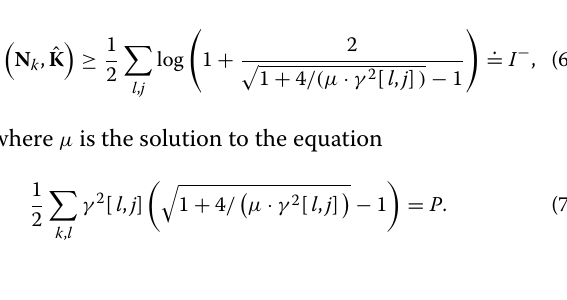
X + Z is minimized when Z is Gaussian with covariance K z . Therefore, for a given covariance matrix of (cid:4) ◦ K